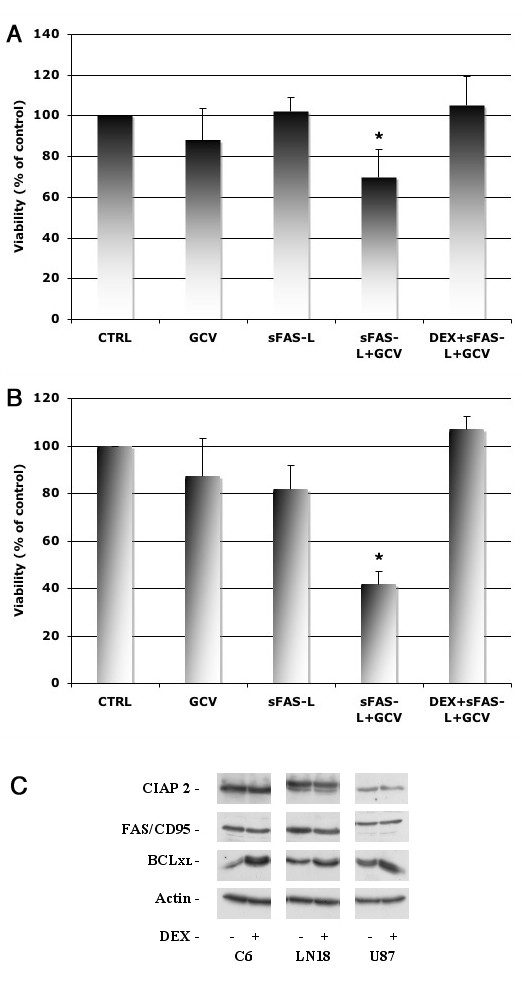
Effect of dexamethasone on FAS/CD95-triggered apoptosis. (A) Viability of C6-TK cells after 24 hours of growth in the presence of GCV, sFAS-L, sFAS-L + GCV and DEX + sFAS-L + GCV, assessed with a MTT test. This viability was significantly altered in cells treated with sFAS-L and GCV and this sensitization was abolished by DEX. (B) Viability of LN18-TK cells after 24 hours of growth in the presence of GCV, sFAS-L, sFAS-L + GCV and DEX + sFAS-L + GCV. This viability was significantly altered in cells treated with sFAS-L and GCV and this effect was abolished by DEX. For both cell types, the viability in the absence of any drug was set as 100 percents. (*: P < 0.05, ANOVA). (C) Western blot analysis of the expression of CIAP-2, FAS/CD95 and BCLXL in C6, LN18 and U87 cells following treatment with DEX (1 μM).